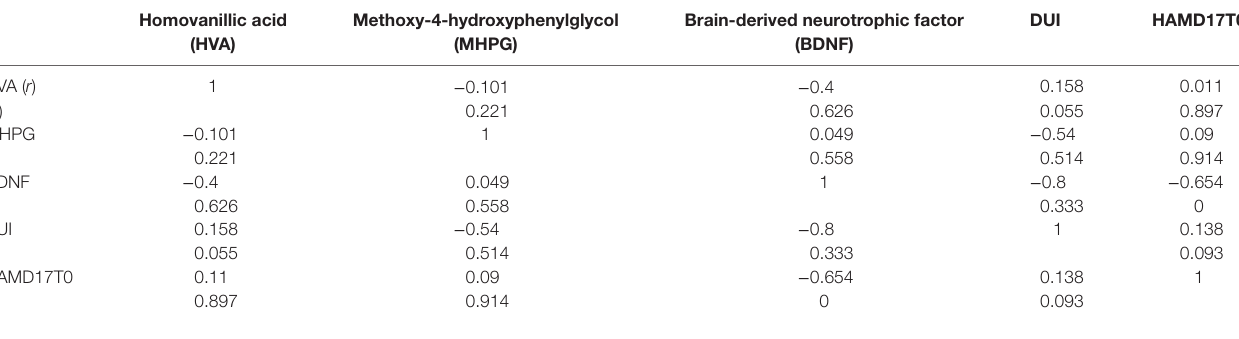
TaBle 2 | Pearson’s correlations